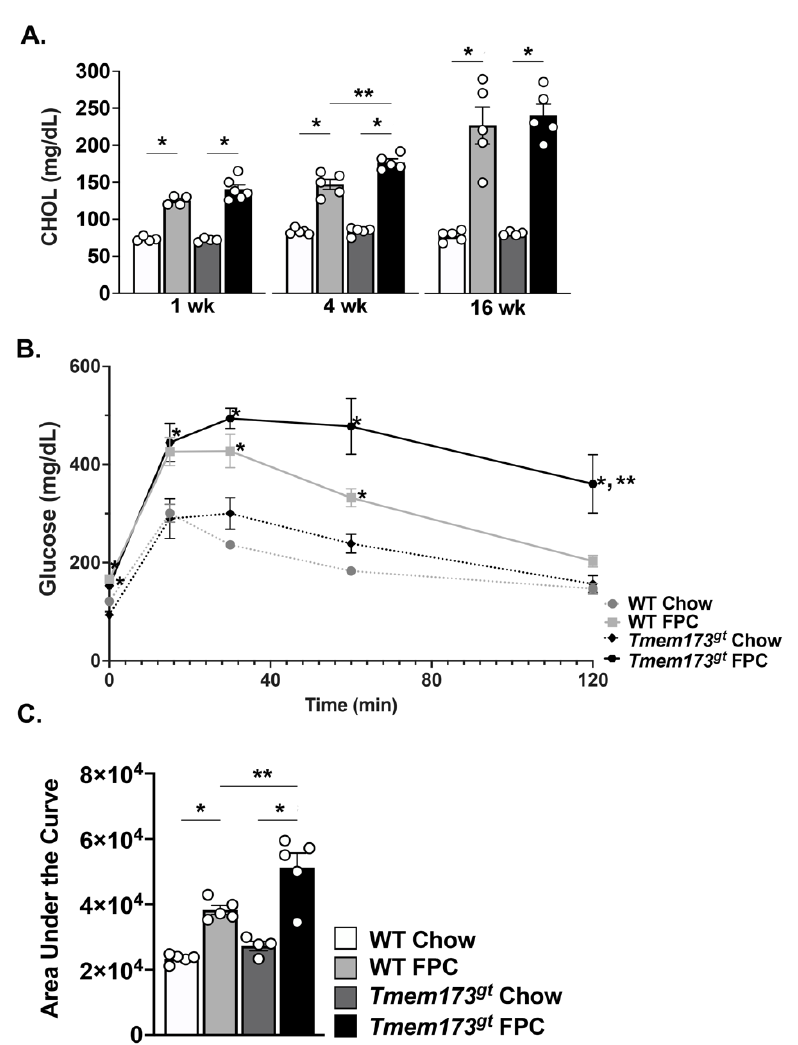
Figure 5. Metabolic measurements in WT and STING-deficient mice during short- and long-term chow and FPC feeding. ( A ) Serum cholesterol levels were measured at 1 wk, 4 wk, and 16 wk post- chow or FPC feeding in WT and Tmem173 gt mice. ( B ) Glucose tolerance test was performed at 15 wk. ( C ) Area under the curve calculated from the glucose tolerance curves above. Graphs represents means ± SEM. * p < 0.05 compared to chow counterpart. ** p < 0.05 compared to WT FPC mice.